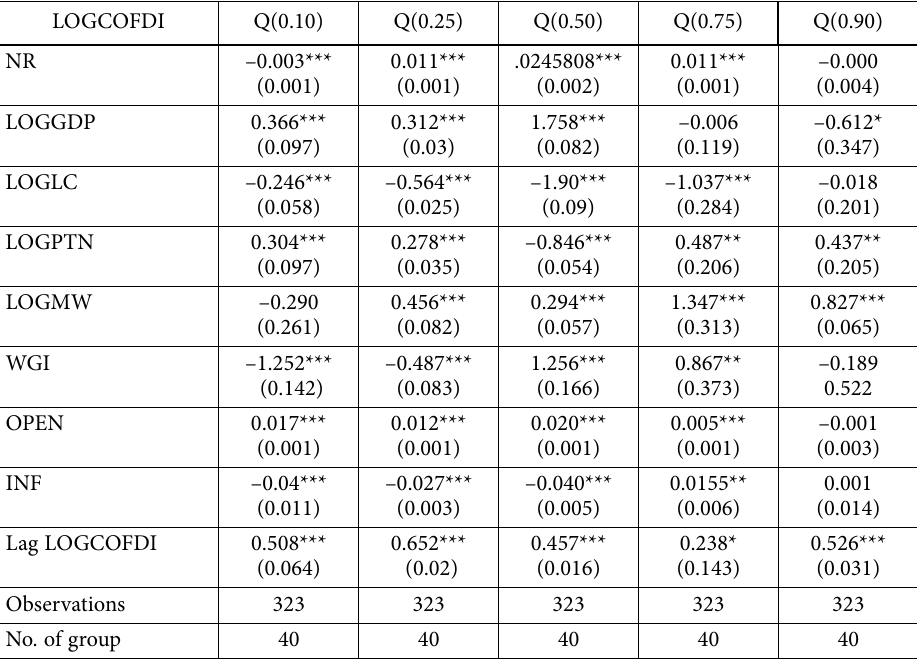
Table 5. Dynamic panel quantile regression for the determinants of China Outward Foreign Direct Investment (COFDI)